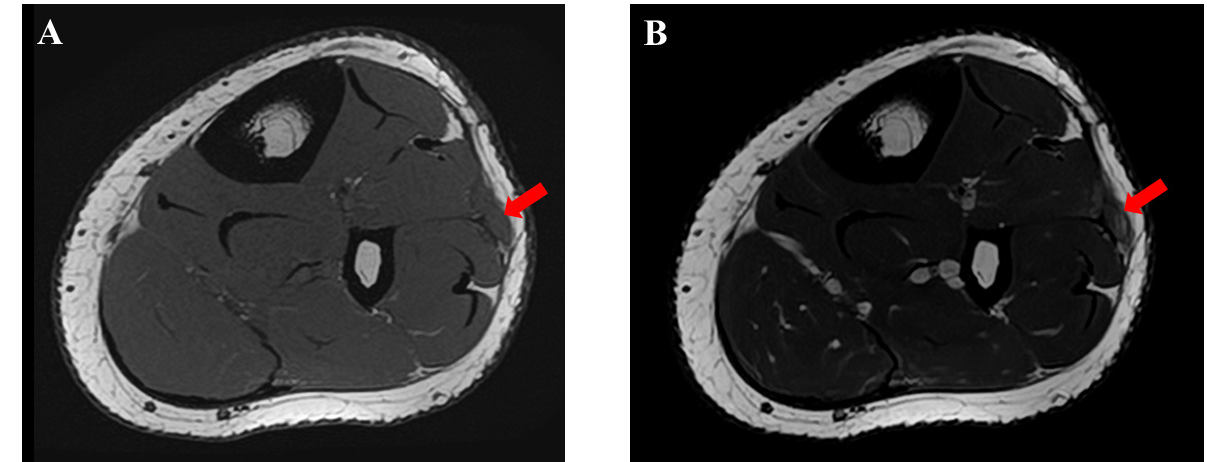
Figure 6. Postoperative magnetic resonance imaging (MRI) findings of the traumatic neuroma of the superficial peroneal nerve (red arrow). ( A ) T1-weighted image. ( B ) T2-weighted image.